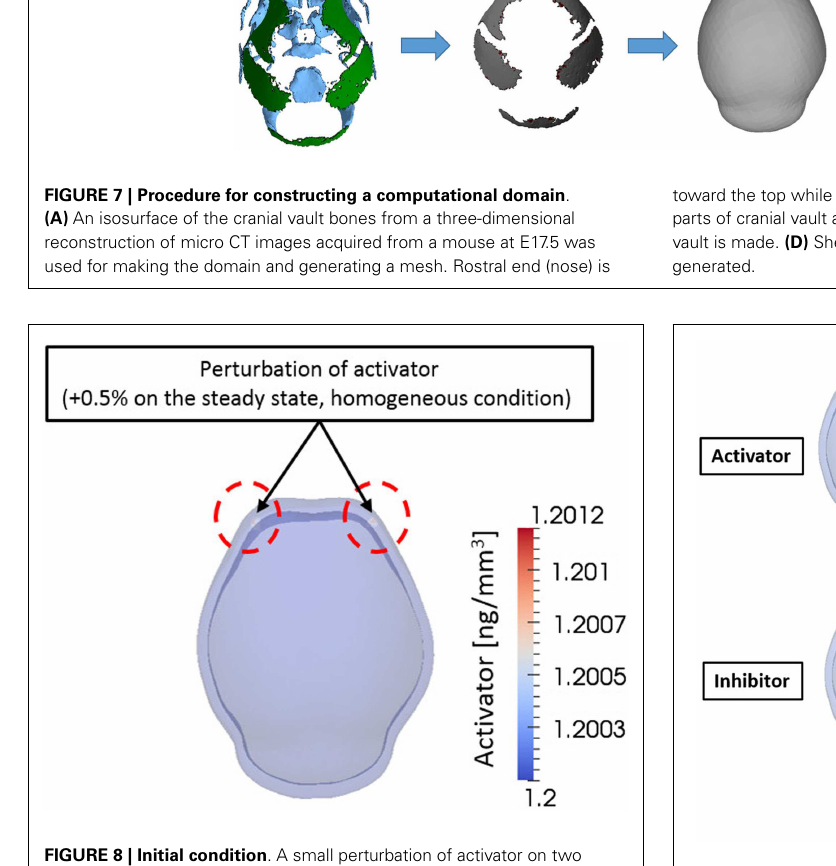
FIGURE 9 | Concentrations of activator and inhibitor at embryonic day 0 and 15.4 from simulation result . Small perturbation of activator at initial time increases through regulatory reaction between activator and inhibitor, and finally makes a specific pattern of concentration of activator and inhibitor after 15.4days. Activator and inhibitor are in phase. Six regions of high concentration of the molecules appear, two on the front, two on the side, one on the rear, and one on the top of the